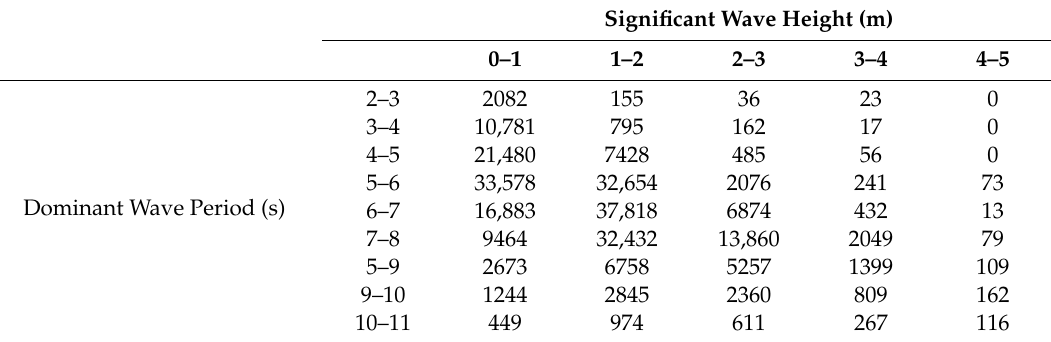
Table 7. Sea states and number of stress cycles.